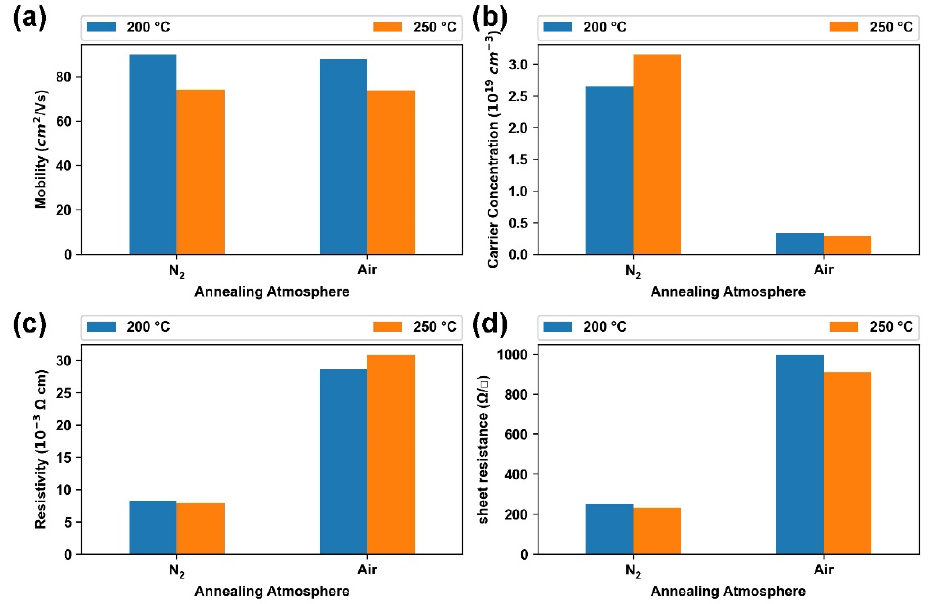
Figure 12. The relationship between electrical properties and annealing atmosphere: carrier mobility ( a ), carrier concentration ( b ), resistivity ( c ), and sheet resistance ( d ).